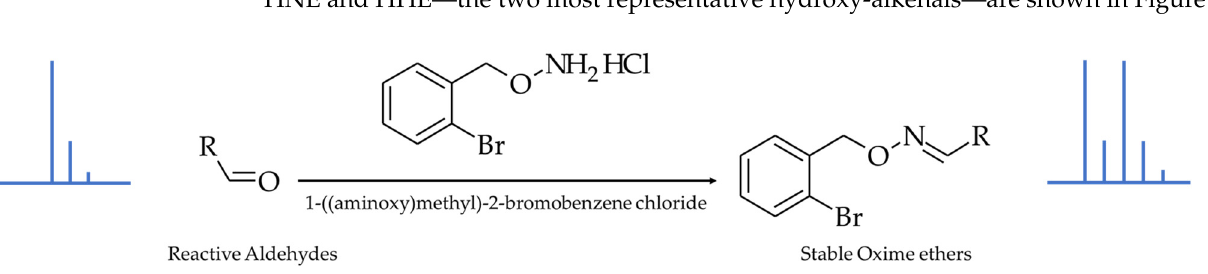
Figure 1. Derivatization reaction and chemical structures of the resulting oxime ethers, showing the introduction of the characteristic brominated isotopic pattern.